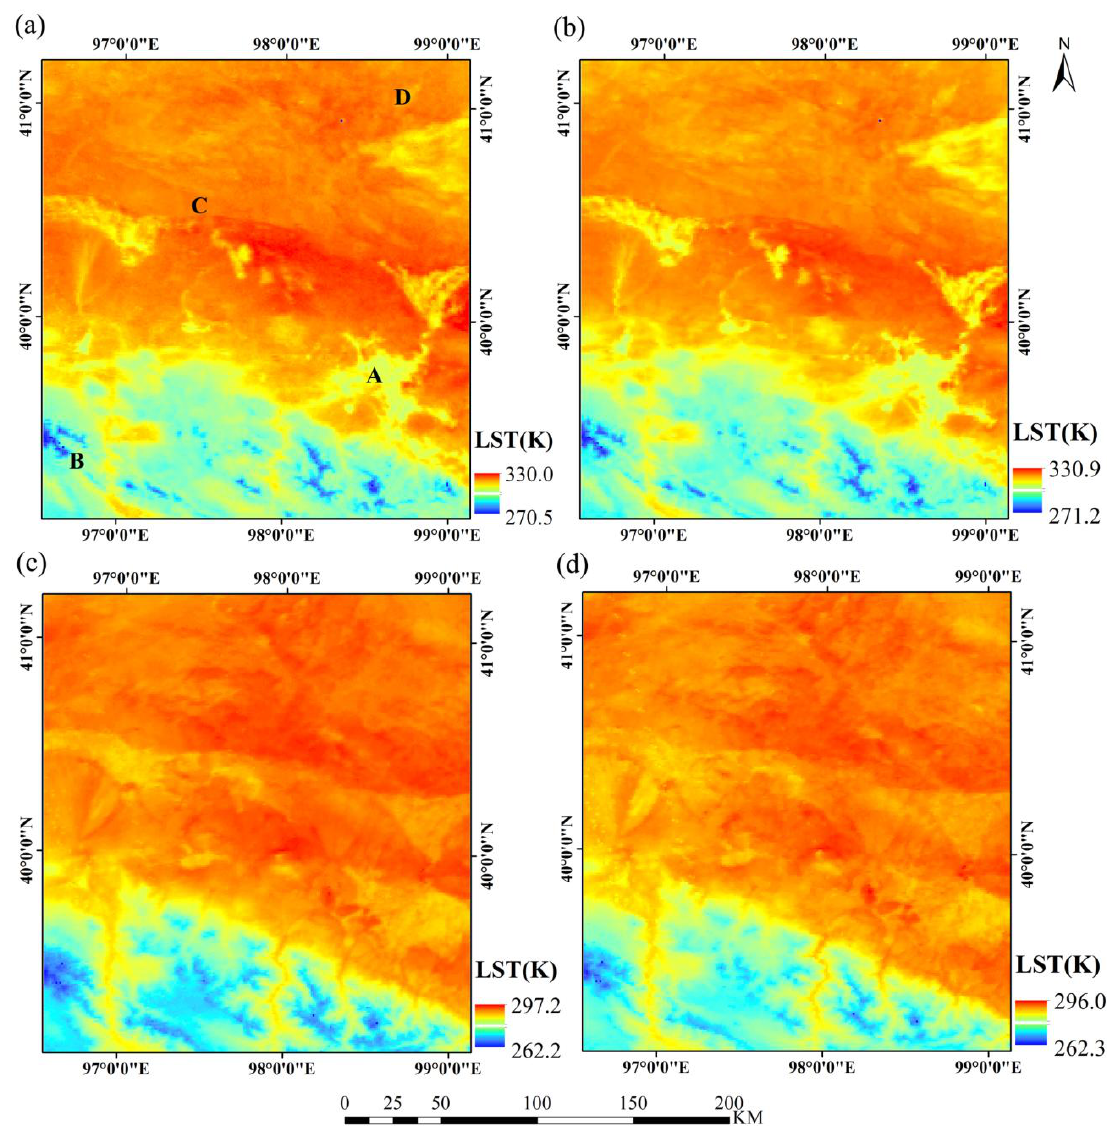
Figure 6. Spatial patterns of the land surface temperature in the study area retrieved by the RM-GA method and those provided by MODIS LST/emissivity products. A is vegetation, B is snow, C is gobi, and D is desert. The MODIS images were acquired on 6 July 2007. ( a ) LST at 04:05UTC retrieved with the RM-GA method. ( b ) LST at 04:05UTC provided by the MODIS LST/emissivity product. ( c ) LST at 15:10UTC retrieved with the